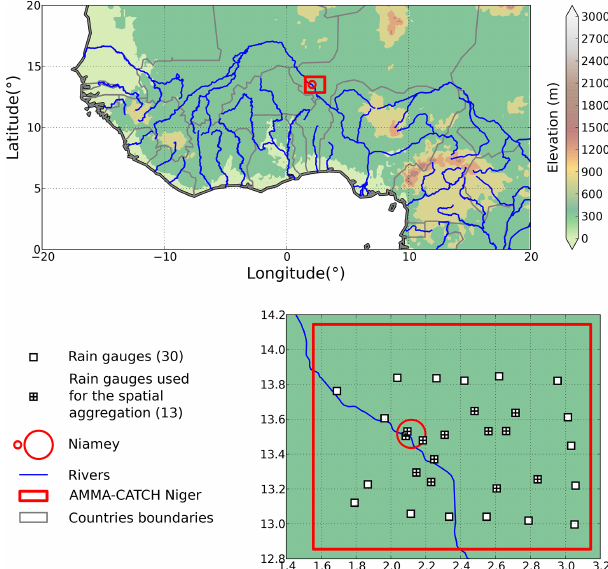
Figure 1. Study area. The background maps displays the elevation